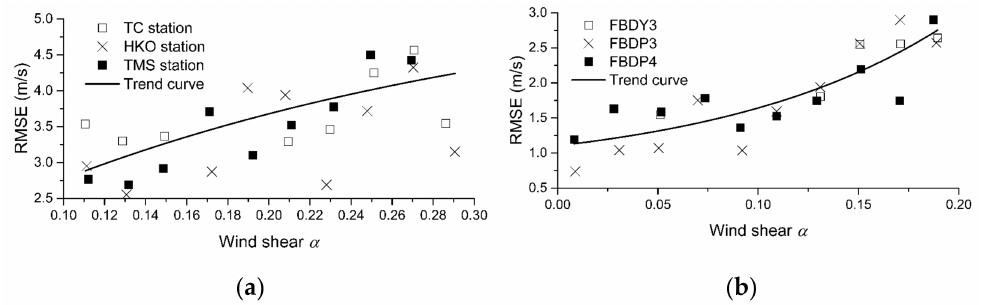
Figure 13. Wind speed error variation as a function of the α . ( a ) RMSE of wind speed over land; ( b ) RMSE of wind speed over the sea.